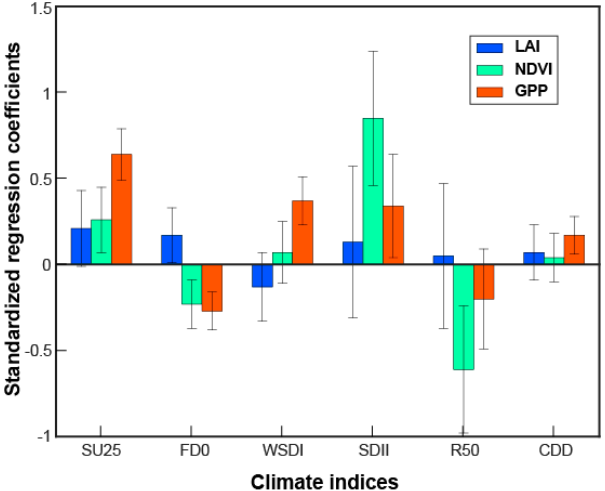
Figure 5. Standardized regression coefficients for the six climate indices in Hubei Province. The error bar represents the standard error for the corresponding regression coefficient in multiple linear regressions.